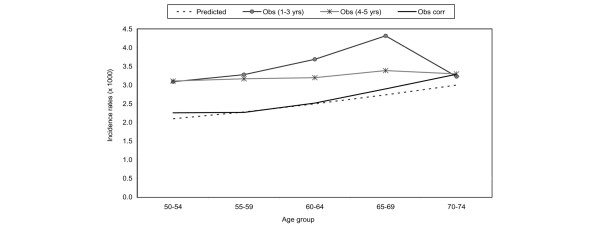
Breast cancer incidence rates by age group and years since the start of the screening.